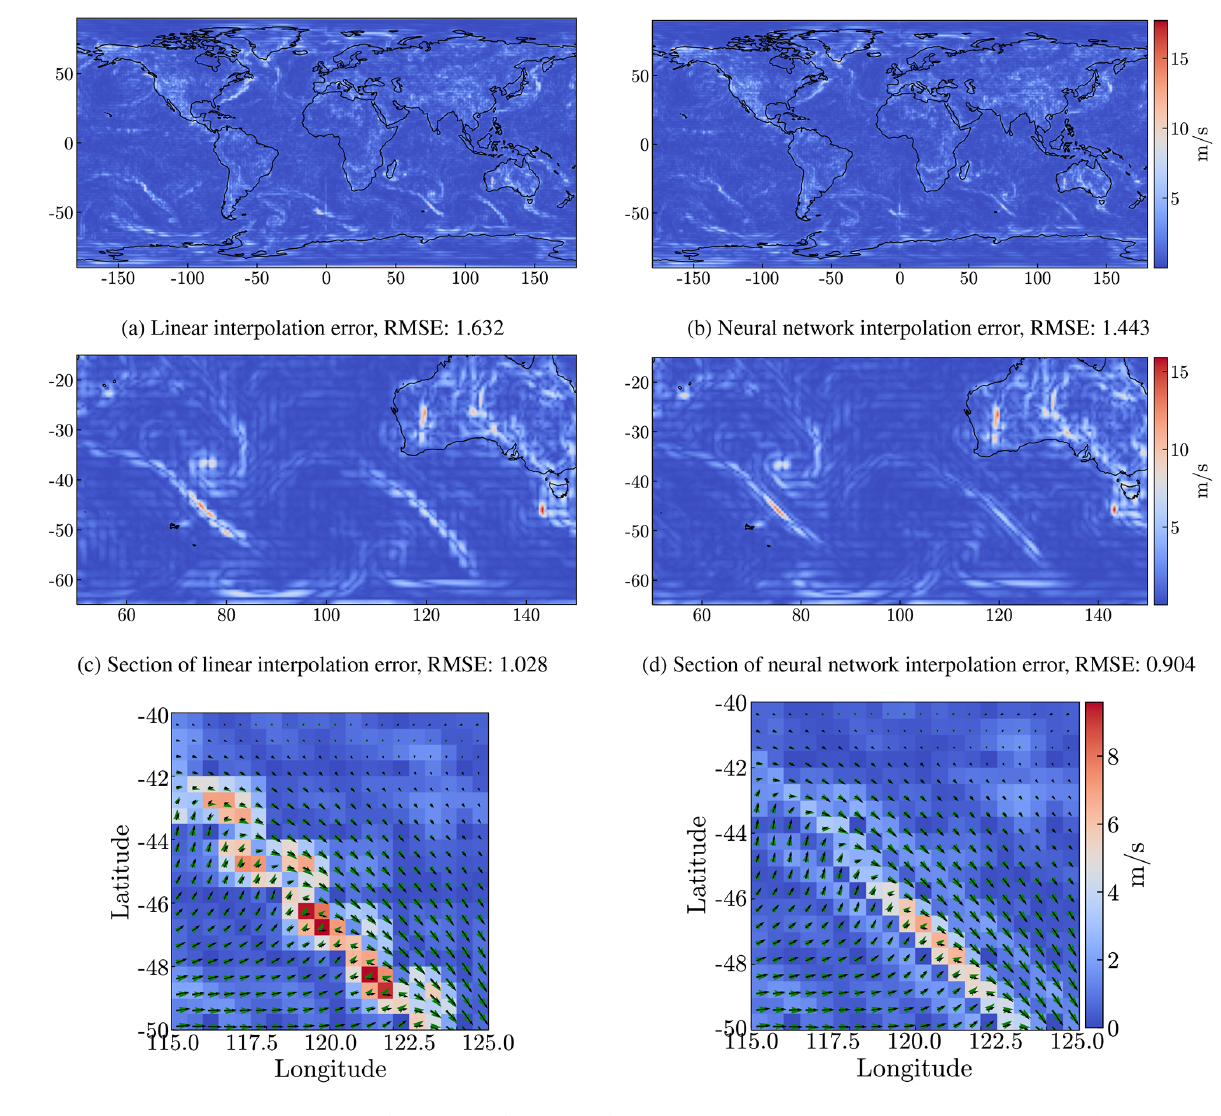
Figure 5. RMSE of v = (u,v) field at level 10 when compared to the truth ERA5 data. The date of the field is the 14 January 2000 at 10:00UTC. Linear interpolation (a, c, e) and the interpolation by the neural network model4 (b, d, f) . The data are interpolated from degraded 2 ◦ × 2 ◦ resolution data. The top row (a, b) shows the error on the globe and the panels below show an enlarged section of the top